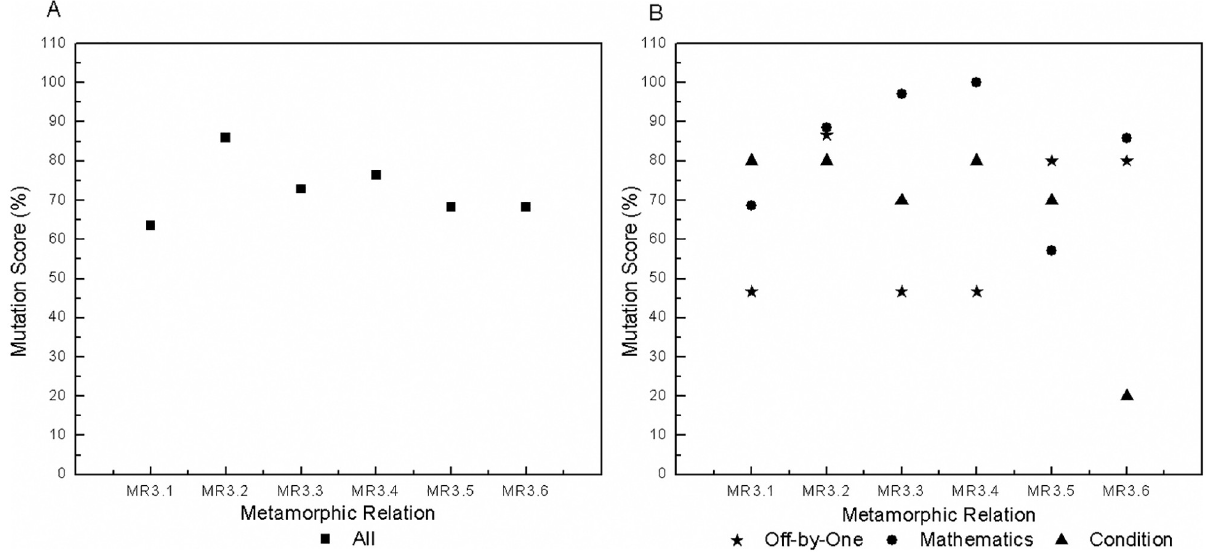
Fig 12. Mutation scores of the MRs based on the same source event sequence h counter deposit,counter deposit,deposit cancellation i . A: Those for all mutants. B: Those for different types of mutants.